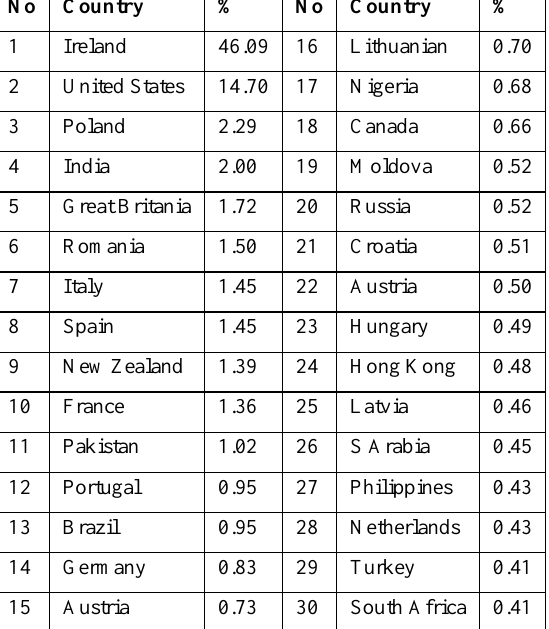
Table 1: Top 30 Identified Nationality in Google POI Review